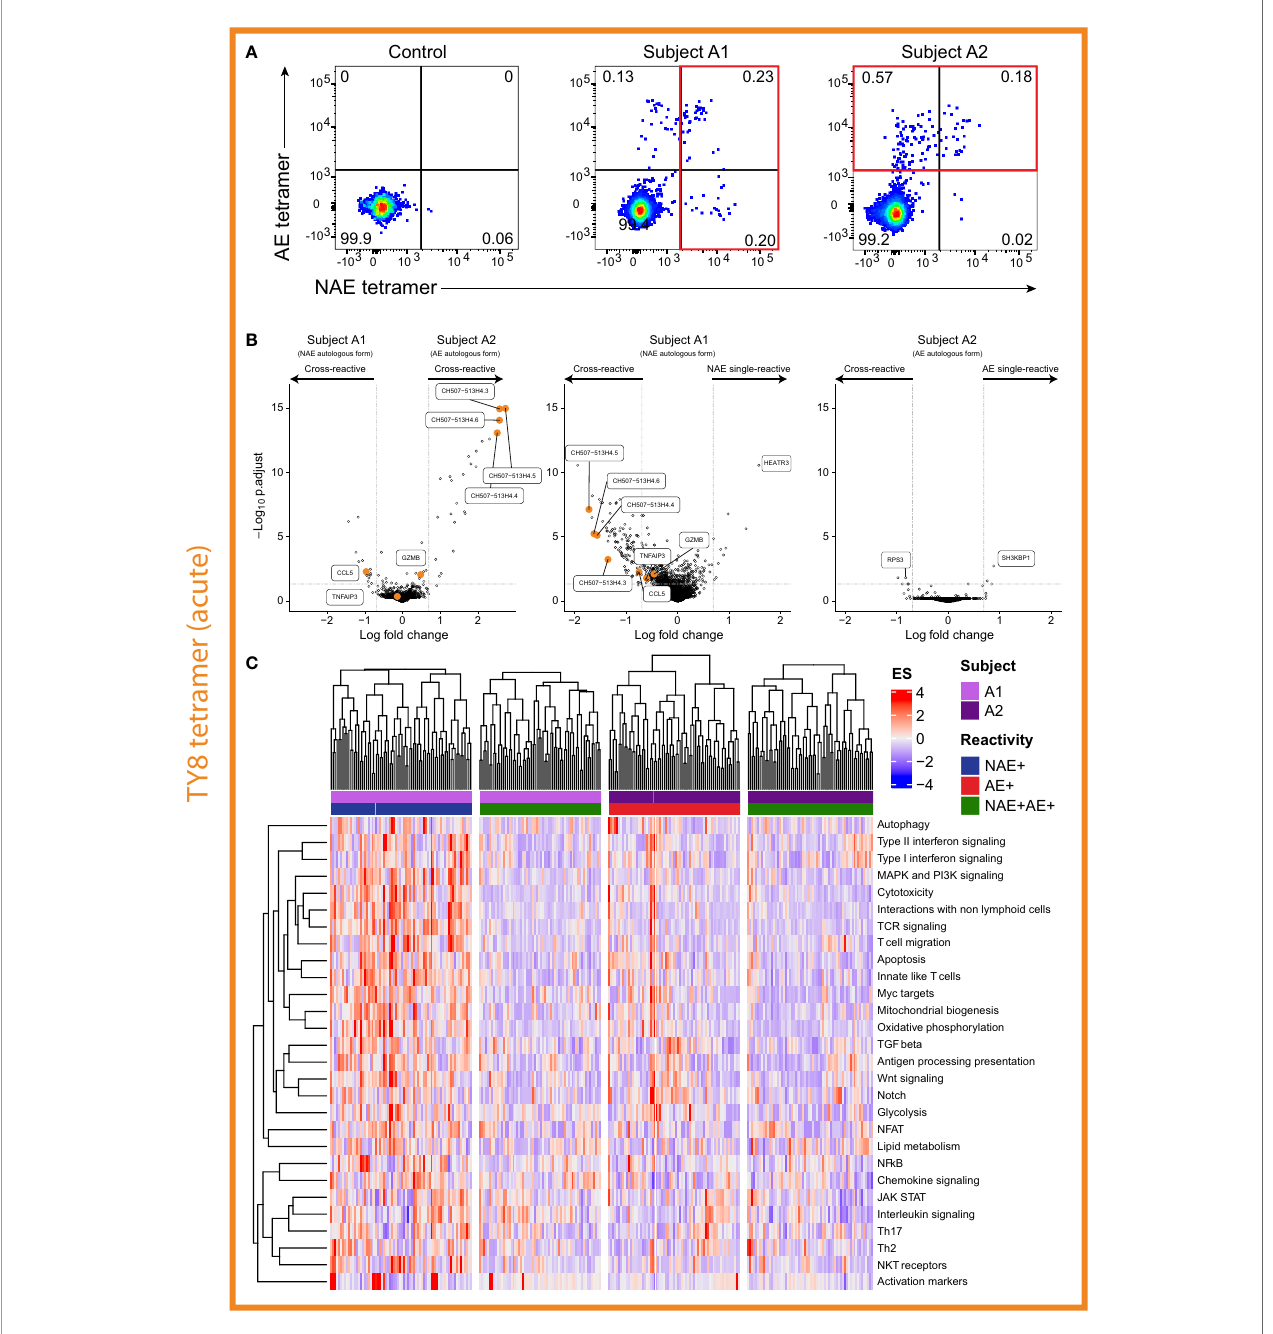
FIGURE 4 | Single-reactive CD8 + T cells in individual with the NAE form of epitope appears to produce a more ‘ effective ’ immune response. (A) Flow cytometry plots for acute HIV-infected subjects A1 and A2 revealed both cross- and single-reactive CD8 + T cells for the epitope TY8. (B) Volcano plots comparing single- and cross-reactive cells for subjects A1 and A2 revealed differences in the number of signi fi cant DEGs based on the autologous form of TY8. Select DEGs observed between cross-reactive resting CD8 + T cells and between NAE and AE stimulated CD8 + T cells in the chronic HIV-infected subjects – i.e. GZMB, CCL5, TNFAIP3 and the CH507 lncRNA family, are highlighted in the volcano plots. Horizontal and vertical dotted lines represent a signi fi cant threshold of an FDR of 0.05 and a fold change of |2|, respectively. (C) Pathway analysis of single- and cross-reactive CD8 + T cells for subjects A1 and A2 revealed a number of signi fi cantly different pathways between the NAE single-reactive CD8 + T cells of subject A1 and the other three CD8 + T cell populations (N =